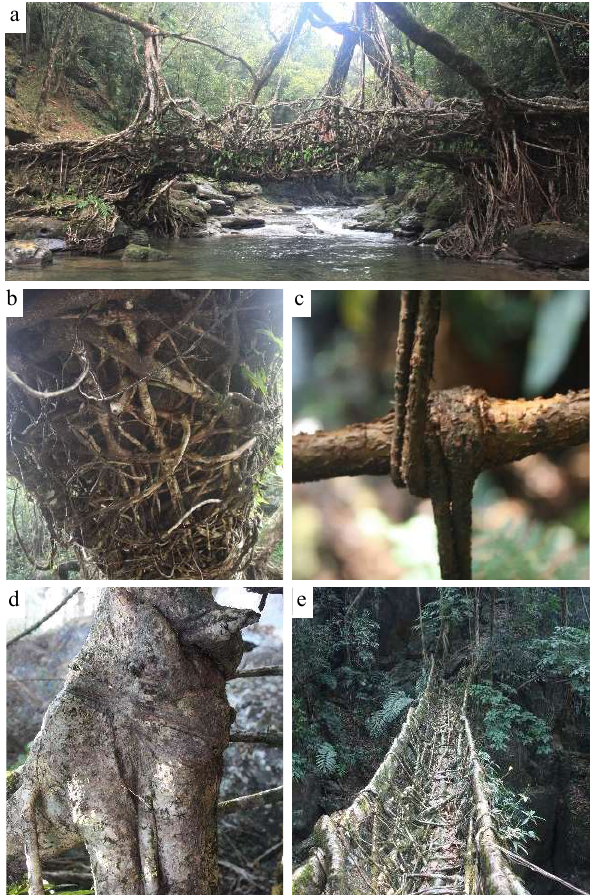
Figure 1: Wah Thyllong bridge (a) is formed of a network of small roots as seen from underneath (b). Roots tied together form inosculated joints, around two years old (c) and much older (d). A small number of long, thick roots are structurally integral to Niah Li bridge